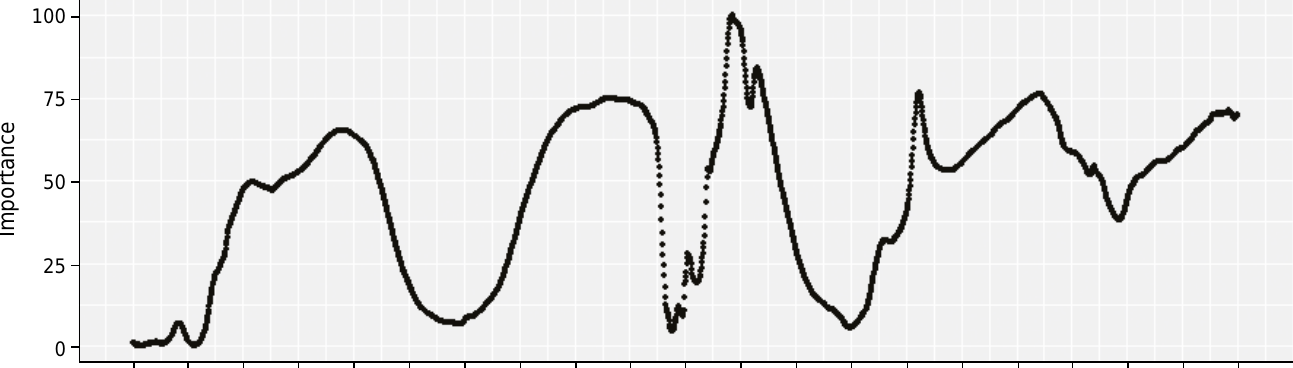
Figure 1. Important variables for clay prediction in the Vis-NIR (Visible and Near Infrared) spectrum using Multiplicative Scatter Correction (MSC) preprocessing and the Support Vector Machine (SVM)